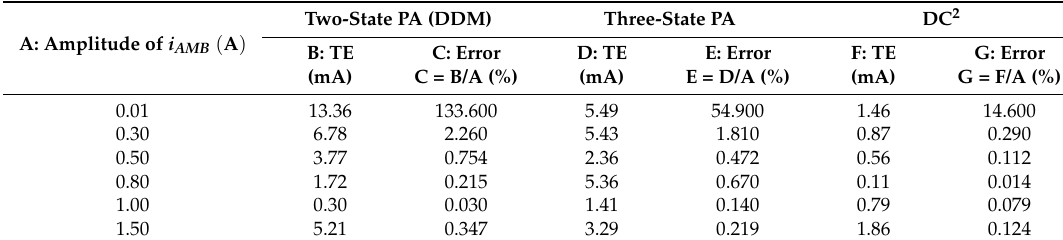
Table 2. Tracking errors on i AMB .